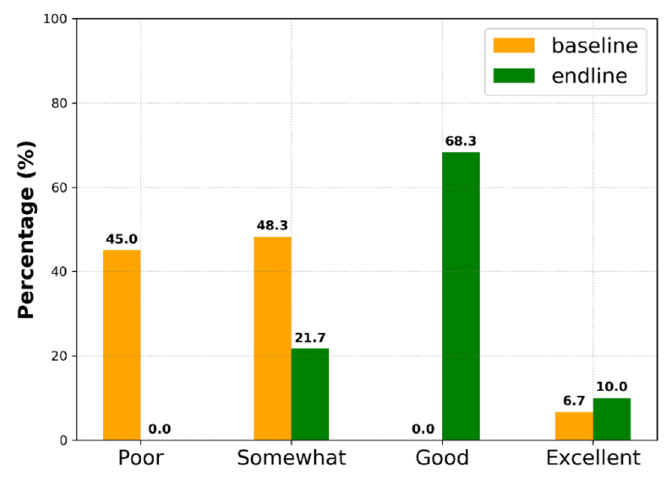
Figure 9. The baseline and endline comparison of farmers’ knowledge of hydroclimatic information in the study area.